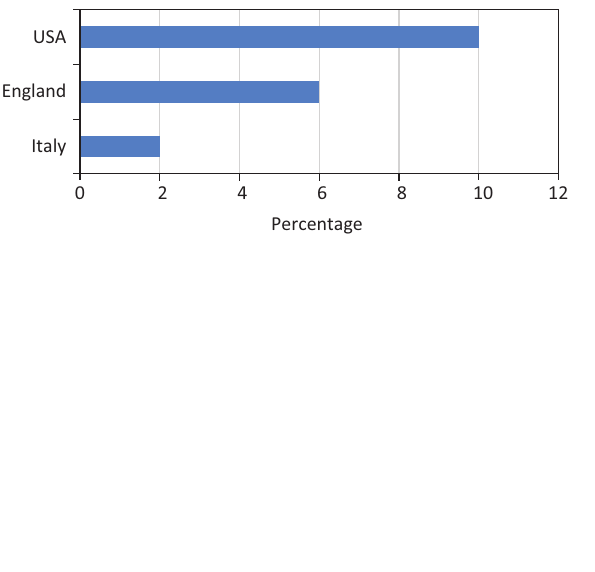
Figure 1. Incidence of “reverse-retirement” among 50–70 year olds by